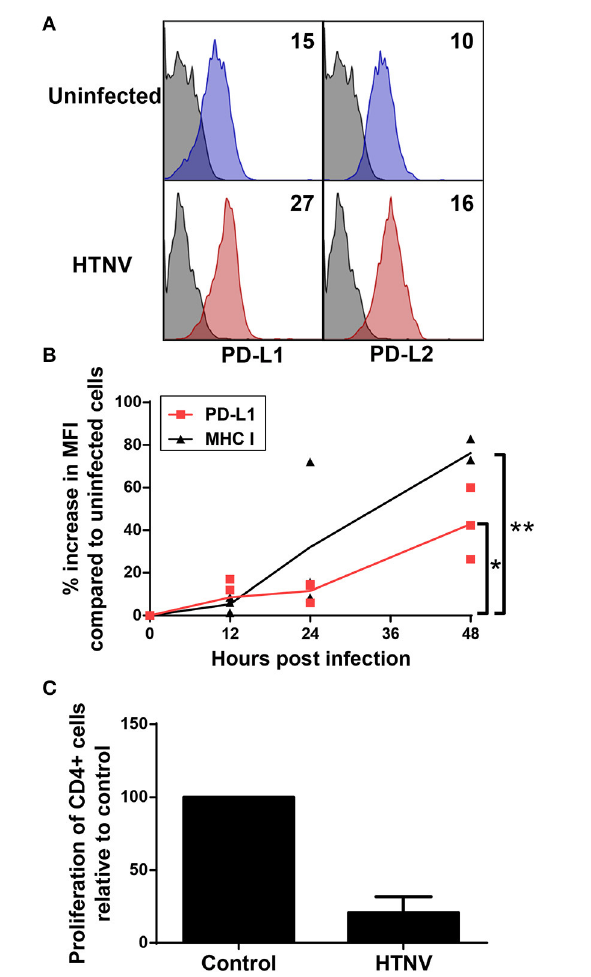
FIGURE 6 | Upregulation of functional PD-L1 and PD-L2 on HTNV-infected endothelial cell lines. (A) HUVECs were infected with HTNV at a MOI of 1.5 and incubated for 4 days before staining for PD-L1 or PD-L2. The results shown are representative of 4 independent experiments using 4 different donors. (B) Human primary fibroblasts (Fi301) cells were infected at a MOI of 1.5 and incubated for 12, 24 or 48h before staining for PD-L1 or MHC class I molecules. Results are derived from three independent experiments (* p < 0.05, ** p < 0.01, paired Student’s t-test). (C) HUVECs infected as for (A) were mixed with allogeneic CD4 + cells at a ratio of 1:4 and treated with PHA at 5 µ g/ml. After 2 days the number cells was measured by MTT dye test (EZ4U-test). Results are derived from three independent experiments using three different donors, error bars represent the mean ± SD. of activated CD8 + T cells (51), significantly increased in PBMCs as compared to uninfected PBMCs ( Figure 7B